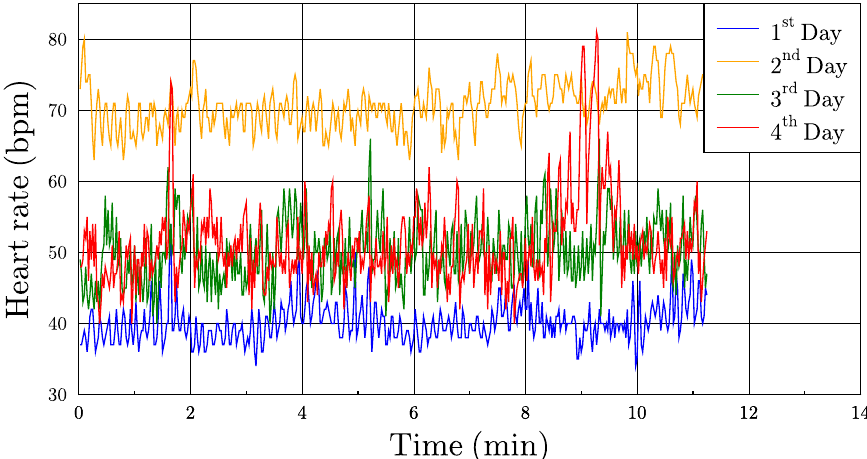
Figure 3. Typical heart rate signal recorded by electrocardiography (ECG). Particular HR signals were pre-processed in order to reduce their time length to 12 min. Different colours indicate particular a measurement day: 1st day, one day preceding the extreme physical effort; 2nd day, the day of the effort; 3rd day, one day following the effort, 4th day, two days following the